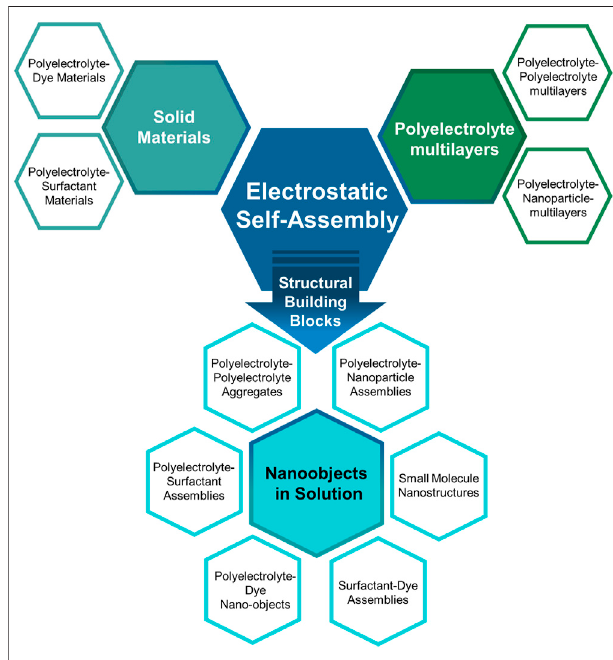
FIGURE 4 | Electrostatic self-assembly: overview of established and emerging